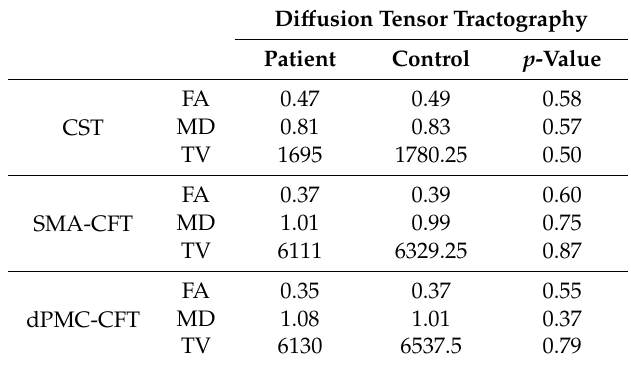
Table 1. Results of the Bayesian statistics analyses of di ff usion tensor tractography (DTT) parameters of the left corticospinal tract (CST) and corticofugal tracts (CFT) of the patient and the control group. Di ff usion Tensor